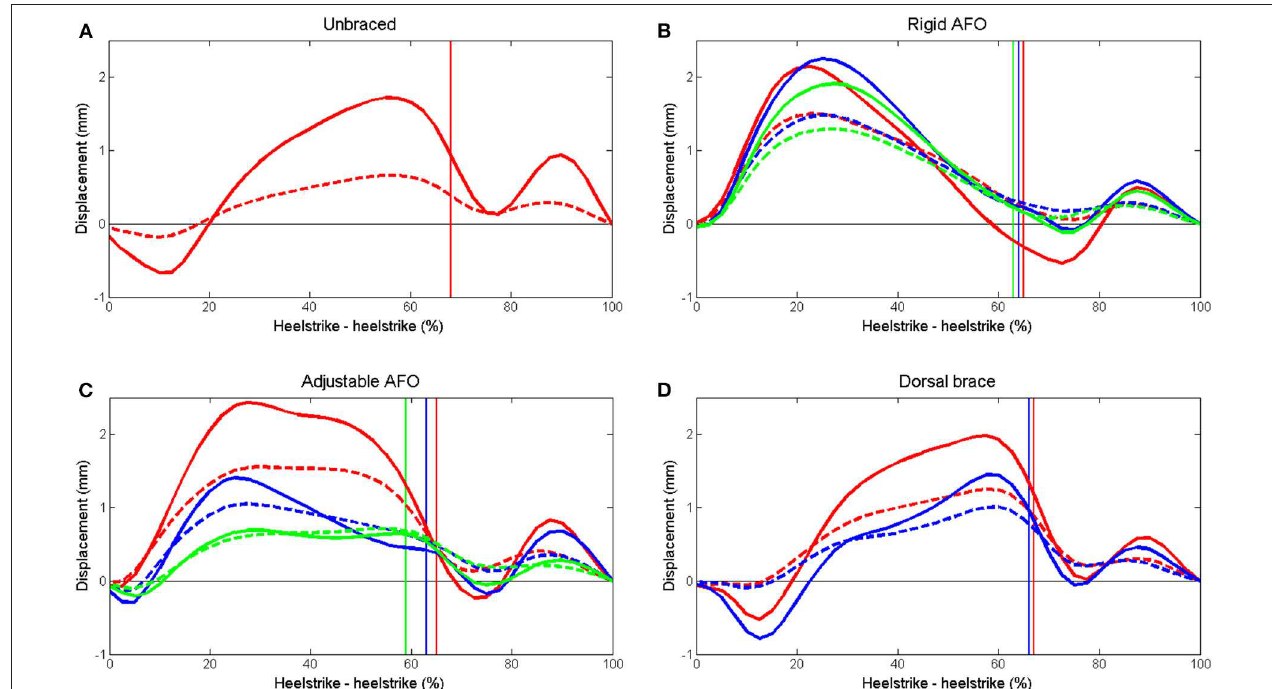
FIGURE 3 | Mean displacement in the superficial (dashed) and deep (solid) layers of the Achilles tendon during walking. (A) unbraced walking, (B) rigid AFO with 0 wedges (red), 2 wedges (blue) and 3 wedges (green), (C) adjustable AFO with ankle dorsiflexion limited to 10 ◦ dorsiflexion (red), 10 ◦ plantarflexion (blue) and 30 ◦ plantarflexion (green), and (D) dorsal brace with 0 wedges (red) and 1 wedge (blue). Toe off time is indicated for each setting by a vertical line in the corresponding color.